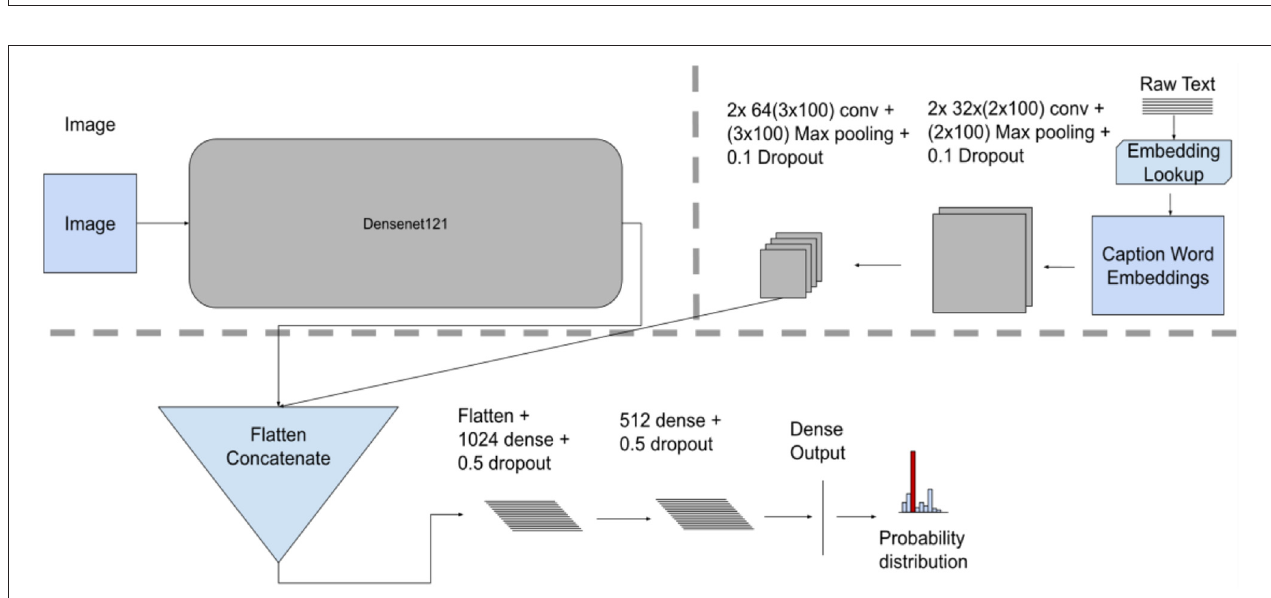
FIGURE 3 | Late fusion model architecture, showing individual unimodal CNN models for images and text along with the averaging fusion mechanism. This method takes independent models and aggregates their results giving a final probability distribution. For both datasets we used the CNN architecture as shown above.